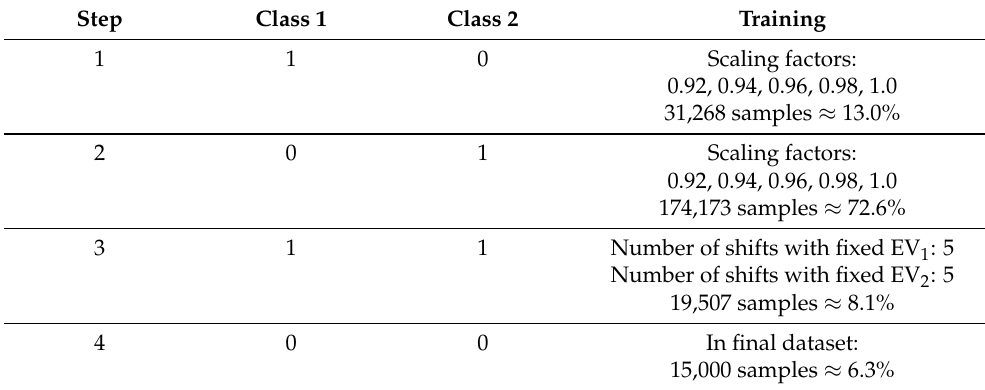
Table 1. Composition of the dataset for training in this paper (0 for inactive, 1 for